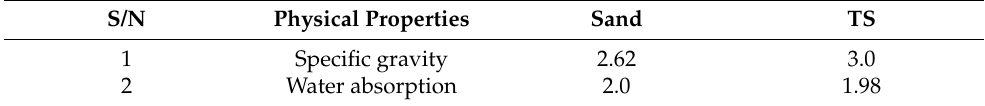
Table 1. Physical properties of fine aggregate and tin slag (TS).